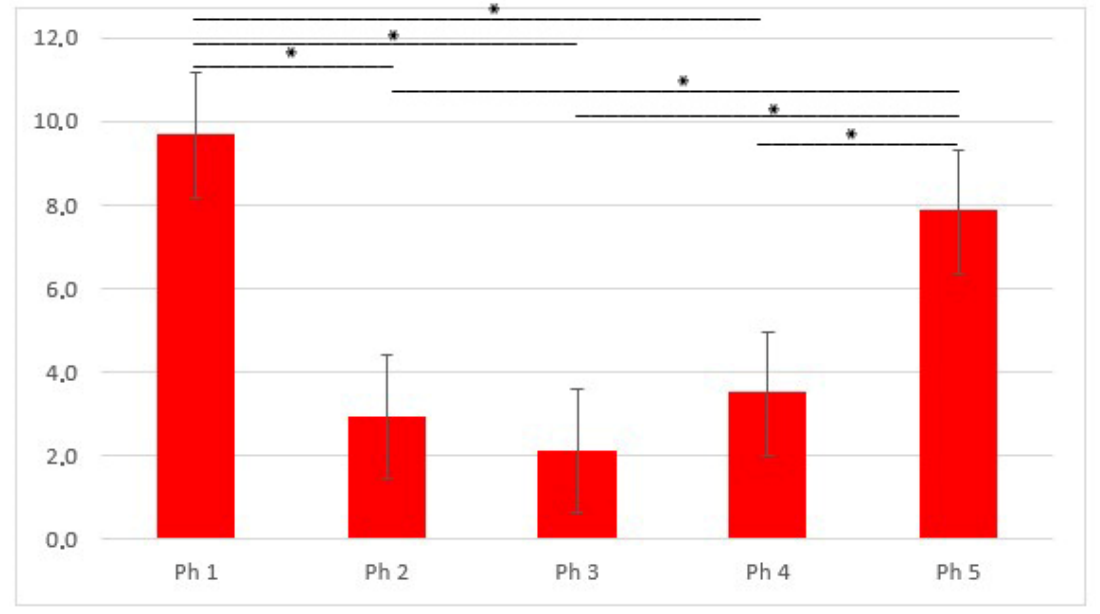
Figure 3. Area percentage scores of DLG1 protein in human fetal and postnatal kidneys. To quantify protein product expression, 20 non-overlapping representative visual fields per DAB-stained sample were captured. Phase one (Ph1), phase two (Ph2), phase three (Ph3), phase four prenatal (Ph4) and postnatal phase (Ph5). Data are presented as the mean ± SE (vertical line) and analyzed by the one-way ANOVA test with Tukey’s multiple comparisons test. Significant differences were indicated by * p < 0.0001.